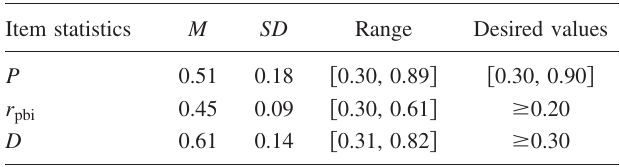
PLOMER et TABLE III. Item analysis: Mean M and standard deviation SD for ten MC questions with item difficulty level P , point biserial coefficient r pbi and (cid:1) internal (cid:2) discrimination index D .